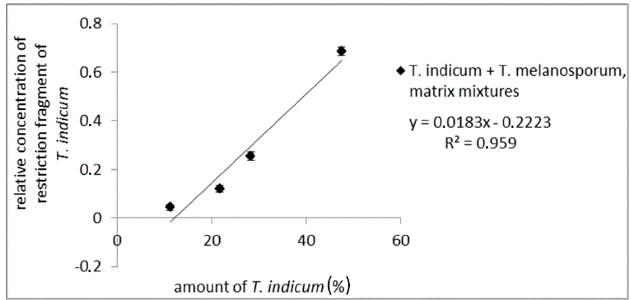
Figure 3. Standard curve of PCR-amplicon mixtures digested with Cvi QI from T. melanosporum with Asian black truffles added to 50%, 40%, and 20%. The concentration of the long restriction fragment of Asian truffles (500 bp) relative to the total concentration of restriction fragments is plotted against Asian truffle amount.